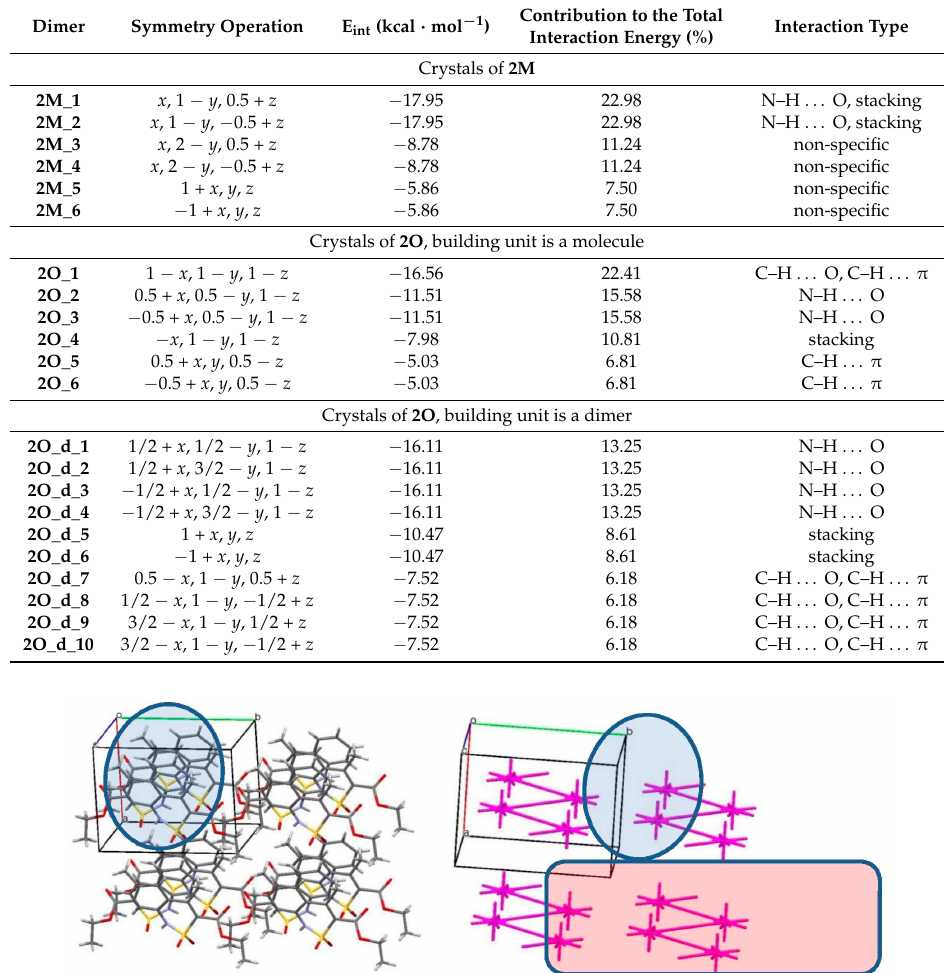
Table 4. Symmetry codes, bonding type, interaction energy of the basic molecule with neighboring ones (E int , kcal mol − 1 ), with the highest values (more than 5% of the total interaction energy) and the contribution of this energy to the total interaction energy (%) in the crystals 2M and 2O .